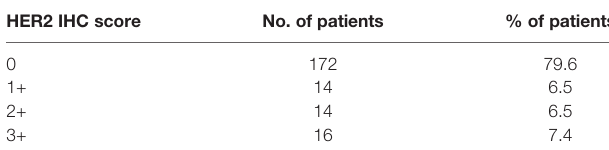
TABLE 2 | HER2 immunohistochemical staining score. HER2 IHC